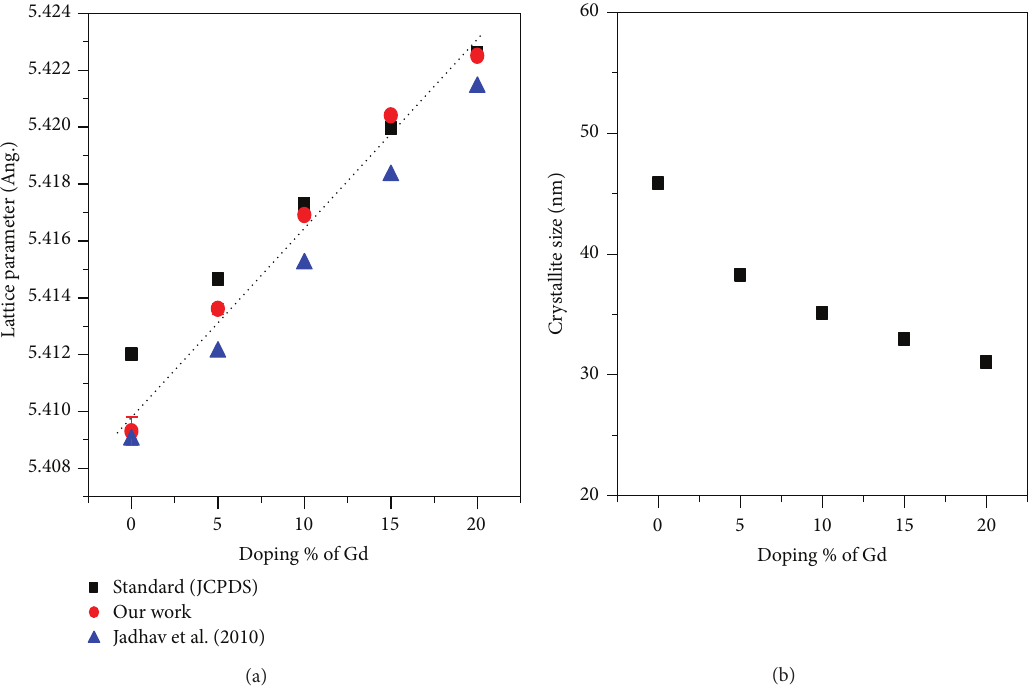
Figure 8: (a) The lattice parameter of GDCX ( X = 0–20%) obtained from a JCPDS database, Jadhav et al. (2010) and our work. (b) The average crystallite size of GDCX ( X = 0–20%) calcined at 800 ∘ C for 8 h in